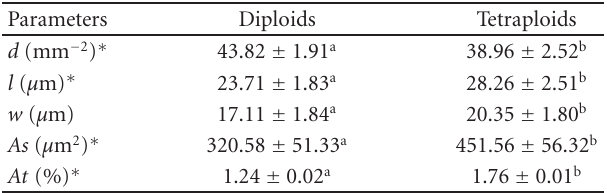
Table 4: Di ff erence of leaf traits between diploid and tetraploid of C. roseus .